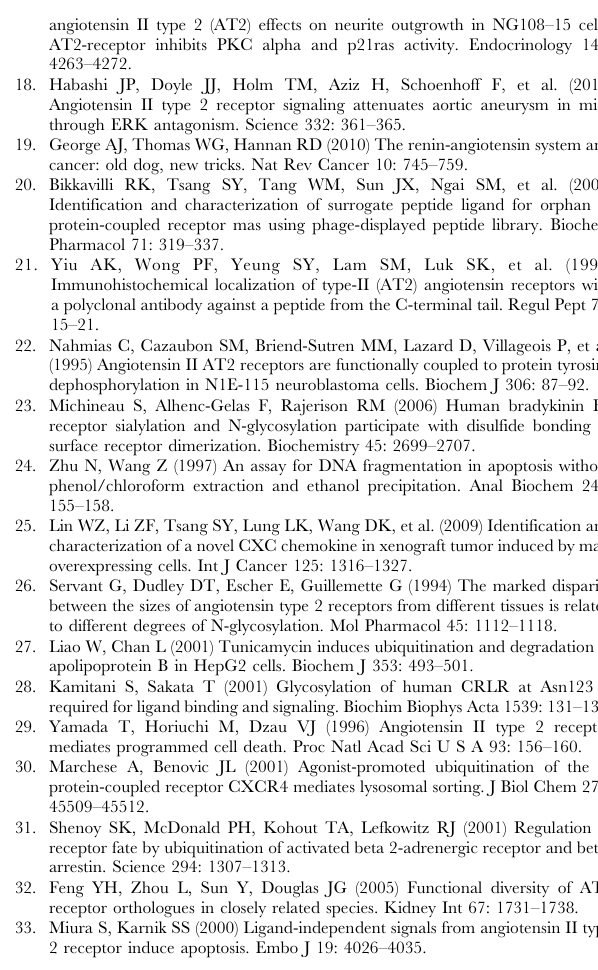
Table S1 Summary of stable cell lines expressing epitope-tagged AT2 receptor variants. Table S2 Summary of AT2 receptor variant expressions in different cell types. Table S3 Cell cycle profile of stable CHO-K1 cell lines expressing epitope-tagged AT2 receptor